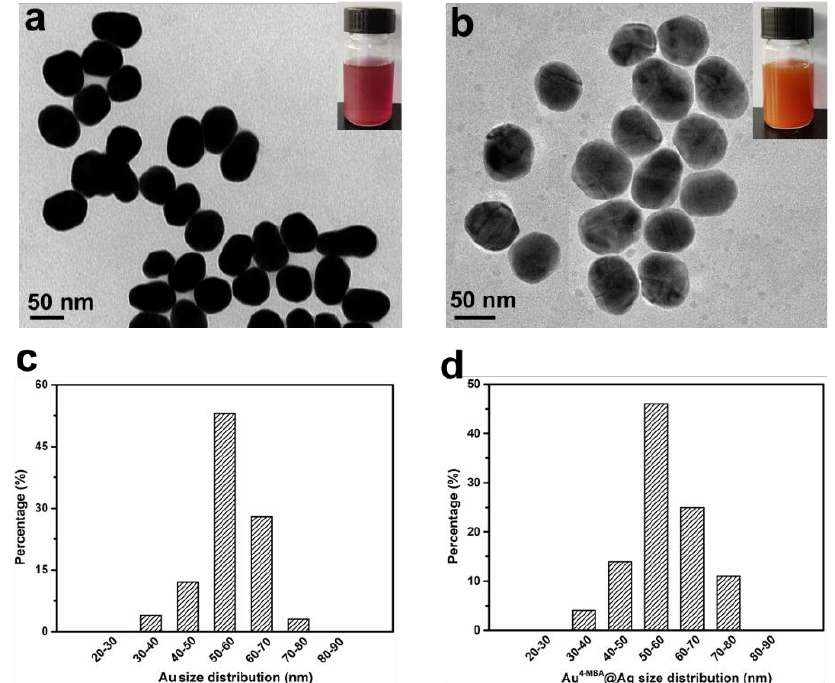
Figure 2. ( a – c ) TEM image and size distribution of Au NPs; ( b – d ) TEM image and size distribution of Au 4-MBA @Ag. Insets of ( a , b ) are the photographs of their corresponding colloidal dispersion.